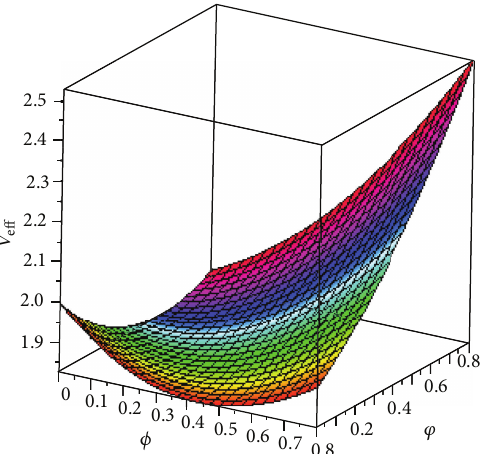
Figure 2: The behavior of the effective chameleon potential with respect to 𝜙 and 𝜑 . The effective chameleon potential reaches a minimum (a line in this case) during its evolution.